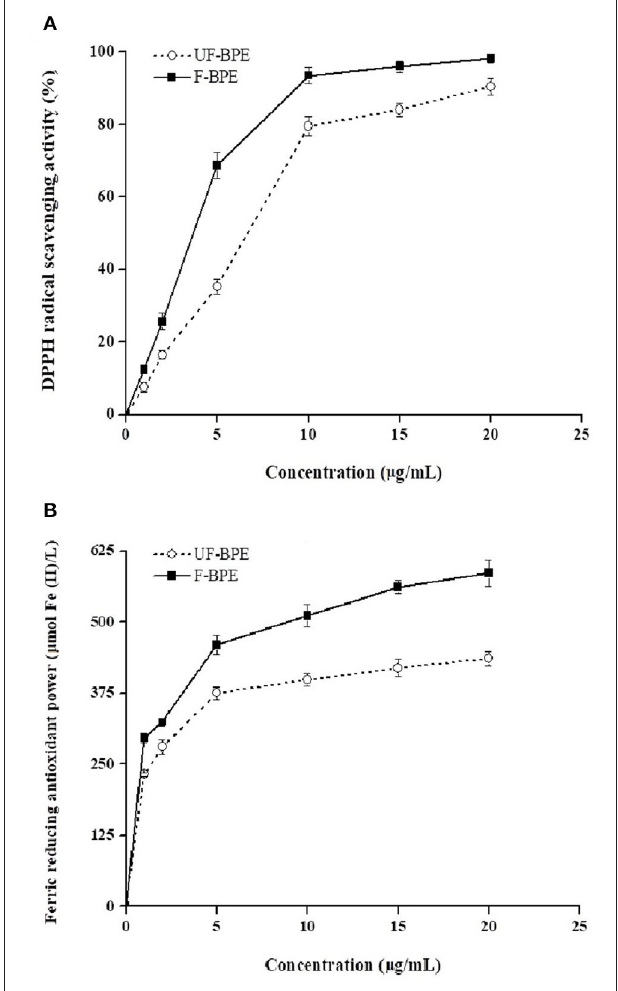
FIGURE 2 | Effects of unfermented barley phenolic extracts (UF-BPE) and fermented barley phenolic extracts (F-BPE) at different concentrations (0.00–20.0 µ g/mL) on (A) DPPH radical scavenging activity and (B) ferric reducing antioxidant power (FRAP). Bars represented mean values ± SD ( n =